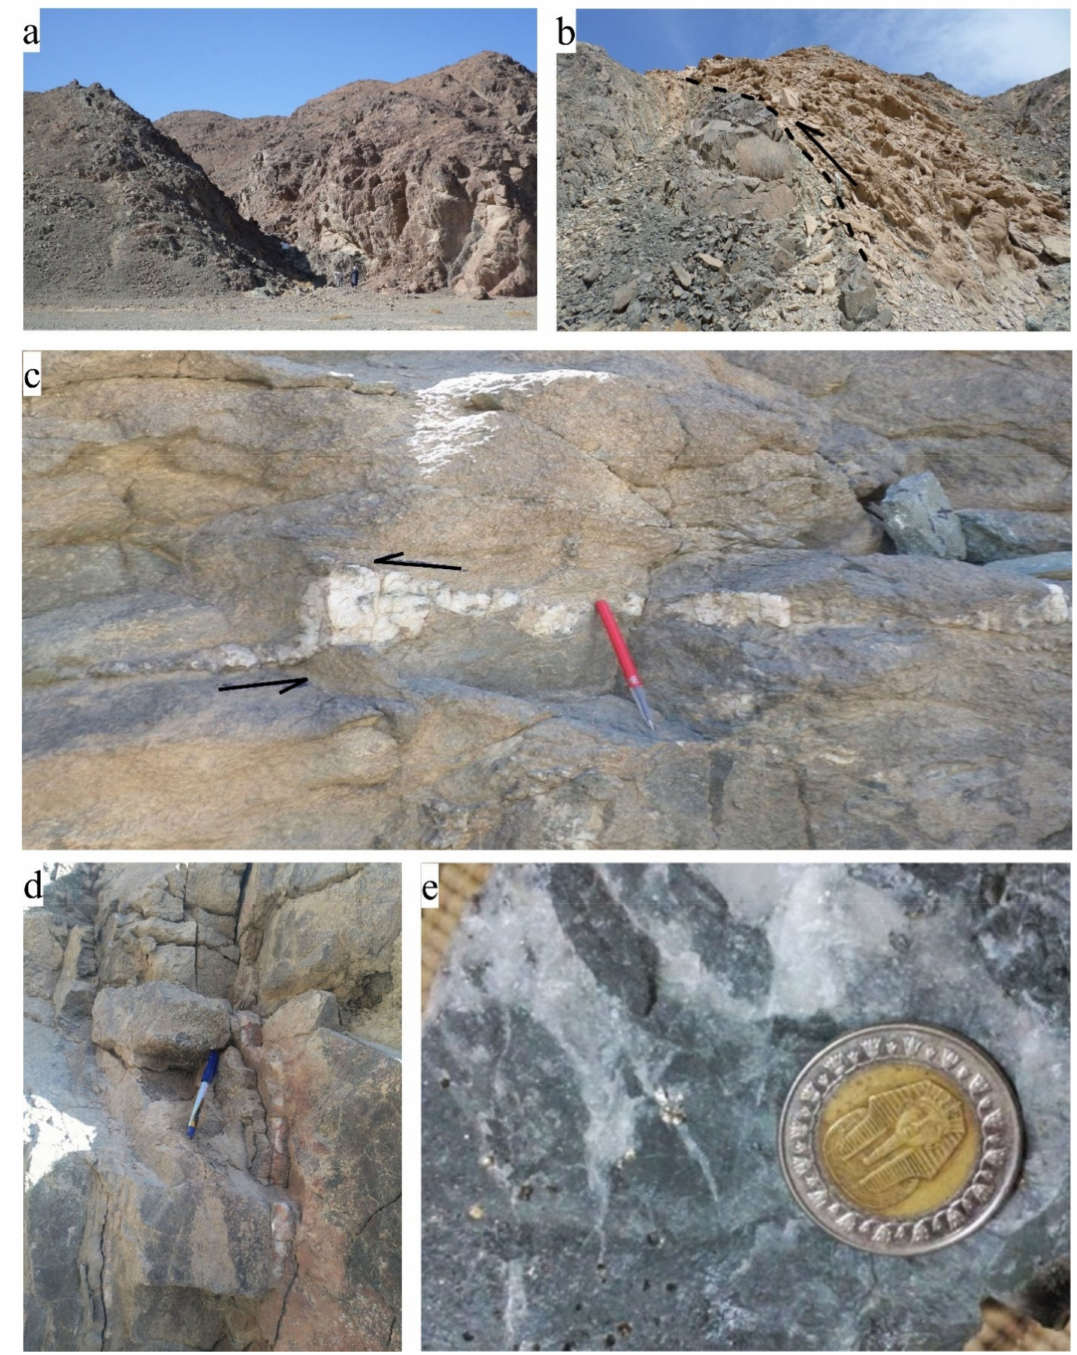
Figure 11. ( a ) Sharp contact between Atalla granite (right) and metavolcanics (left), ( b ) NW trending thrust contact between talc-carbonates (right) and metavolcanics (left), ( c ) sinistral sense of shearing marked by asymmetric delta-type quartz porphyroclast in granitic rocks, ( d ) mixed alteration minerals (kaolinite and sericite) binding a small-scale quartz vein, and ( e ) disseminated golden sulfides (e.g., pyrite) in milky white and grey quartz, in a hand